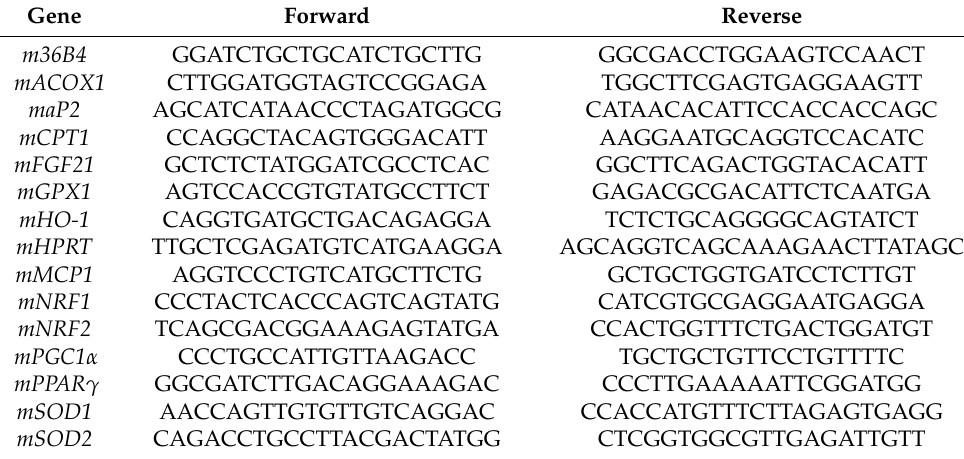
Table 2. Primer sequences for real-time